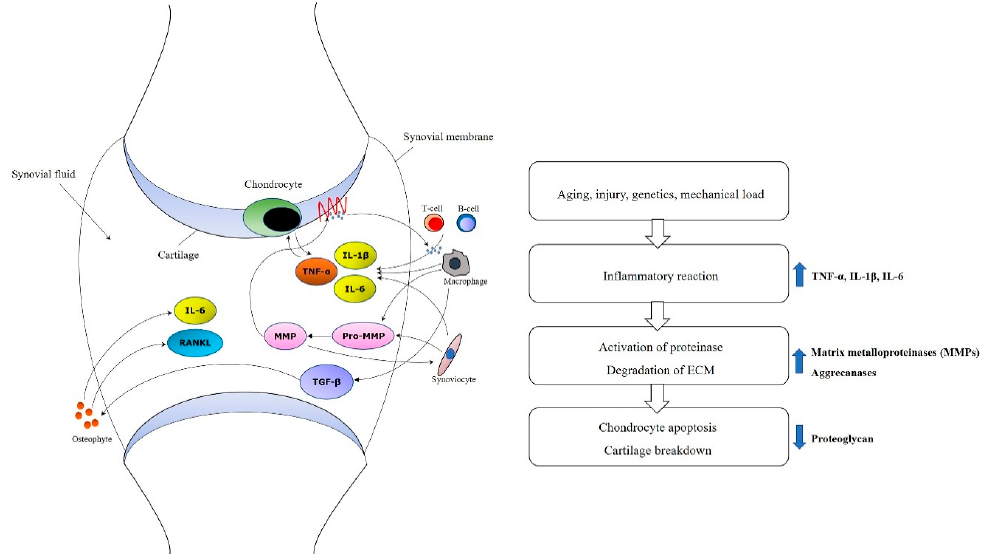
Figure 1. Molecular mechanisms of osteoarthritis. Increased proinflammatory cytokines such as TNF- α , IL-1 β and IL-6, activated matrix metalloproteinases (MMPs), and decreased growth factors such as TGF- β and ultimate chondrocyte senescence can be observed at the molecular level.